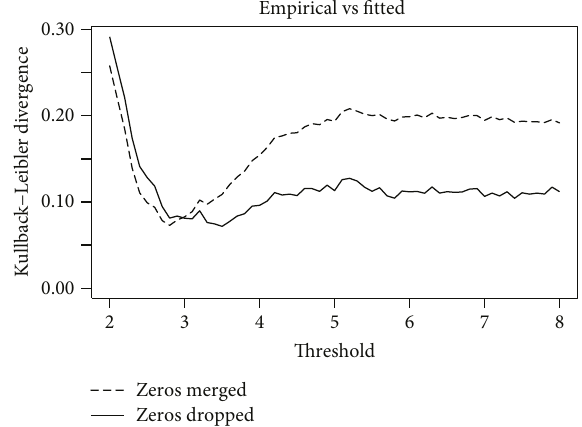
Figure 3: Di ff erence in frequencies between avalanches of size 1 and avalanches of size 2 as a function of the dichotomization threshold (ignoring P values).